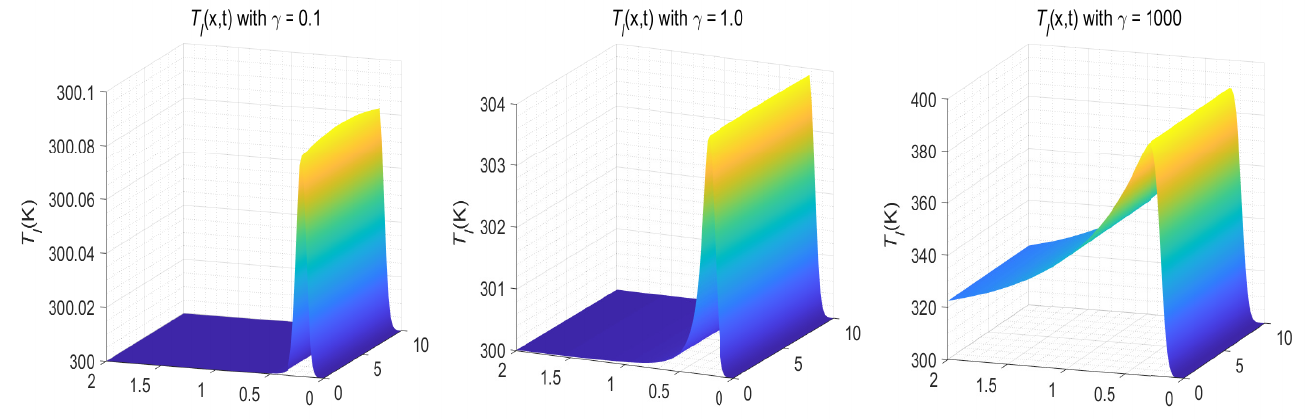
Figure 17. Temperature distributions of T l versus ( x , t ) with various γ when K n = 61.84658, ( α , β ) = ( 0.8,0.3 ) , N = 100, and M = 100 for Example 2.